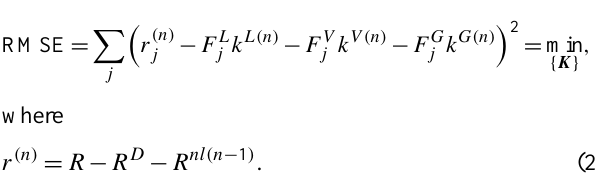
Figure 2 . Comparison of the envelope of 15 April ground-measured albedos covering five sites (lines) with CAR albedos obtained on 7 April (triangles) and 15 April (circles) at the Elson Lagoon site.